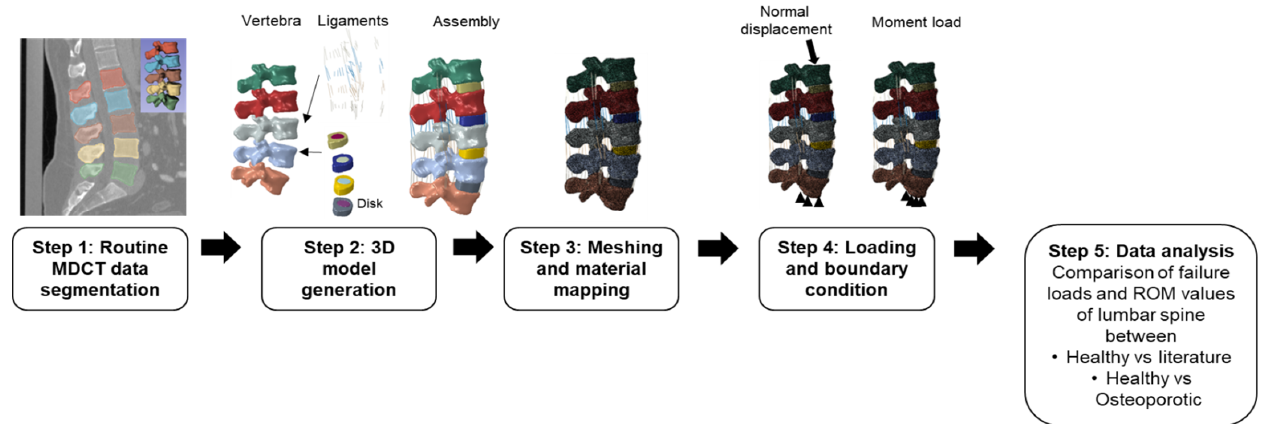
Figure 1. Schematic representation of the five-step modeling methodology used in this study for routine clinical MDCT image processing, modeling, and data